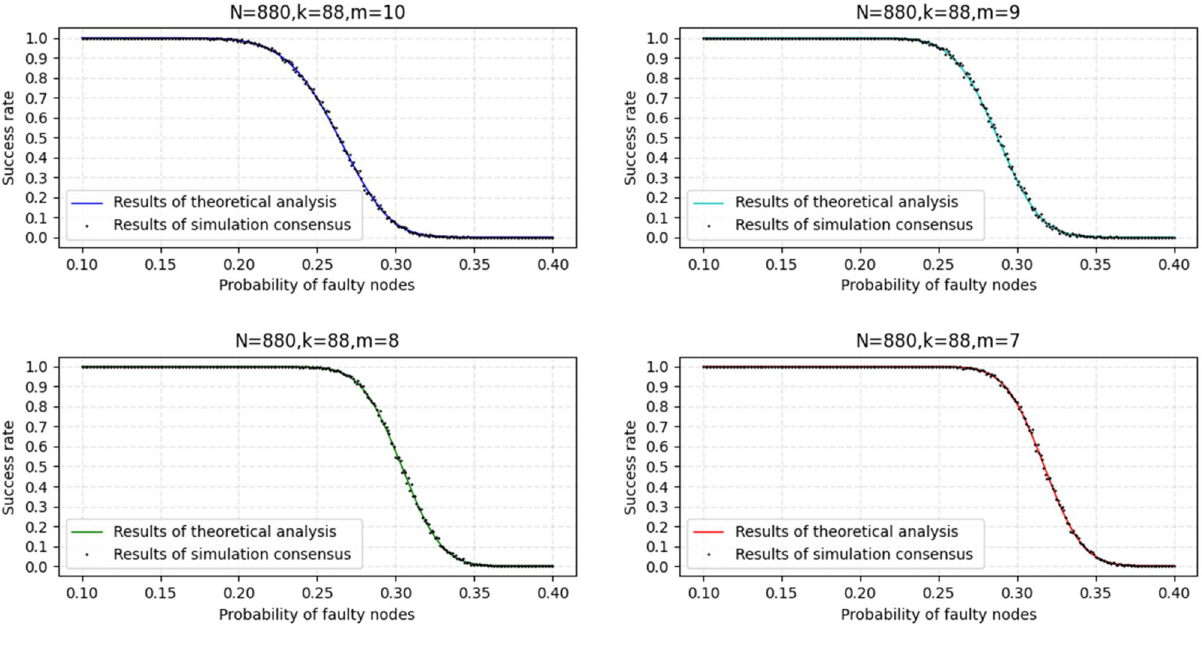
Figure 11. Simulated consensus results.